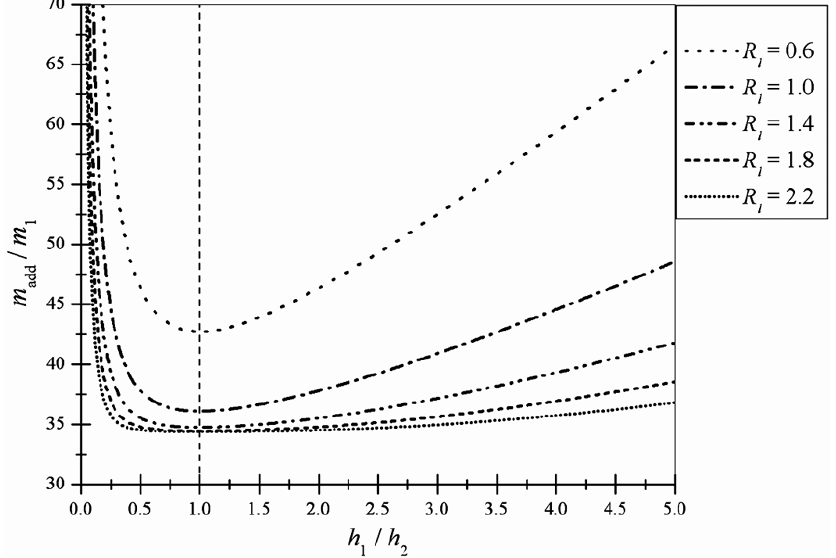
Fig. 3. Effect of plate position in a tank on added mass of a partially submerged